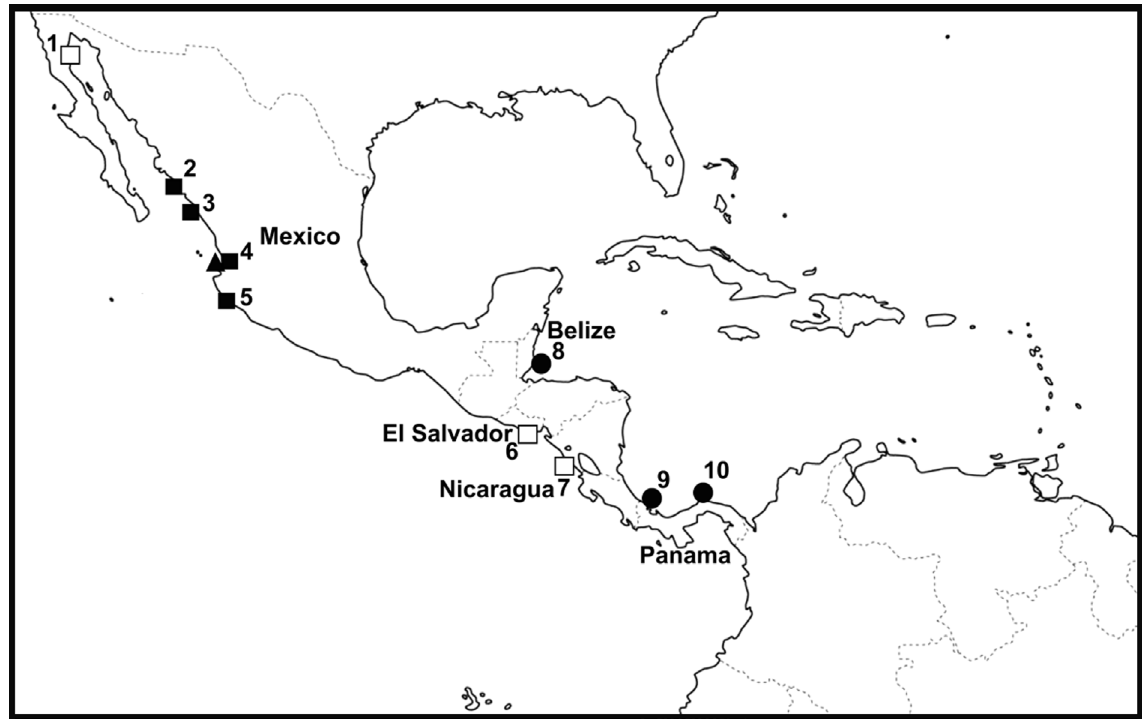
Figure 1. Localities in which the Austinixa species indicated in this study have been collected. Austinixa marianae sp. nov. = dark triangle, A . roblesi (according to Palacios Theil and Felder (2020a)) = dark circles, and A . felipensis = squares. The dark squares correspond to the collection locations in this study, the empty squares indicate the localities of collection, according to Glassell (1935), Bott (1955), and Palacios Theil and Felder (2020a). The numbers correspond to: 1, San Felipe, Baja California; 2, Santa María - La Reforma, coastal lagoon, Sinaloa; 3, Mazatlán, Sinaloa; 4, La Cruz de Huanacaxtle, Nayarit; 5, Bahía Chamela, Jalisco; 6, Coral de Mulas and La Chepona, El Salvador; 7, Las Enramadas, Nicaragua; 8, Dangriga, Belize; 9, Bocas del Toro, Panama; 10, Isla Grande,